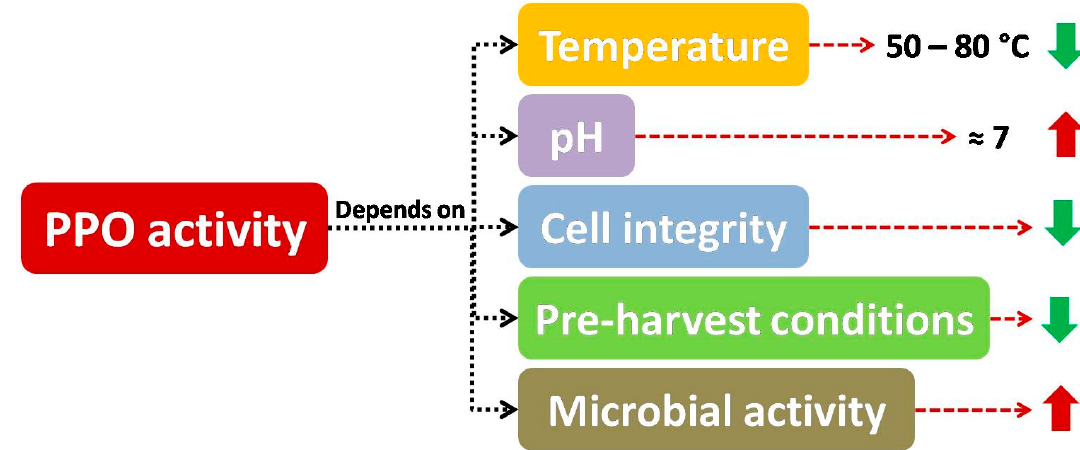
Figure 7. Influence of main factors on PPO activity, indicating its positive (green down arrow) or negative effect (red up arrow) and some specific conditions.